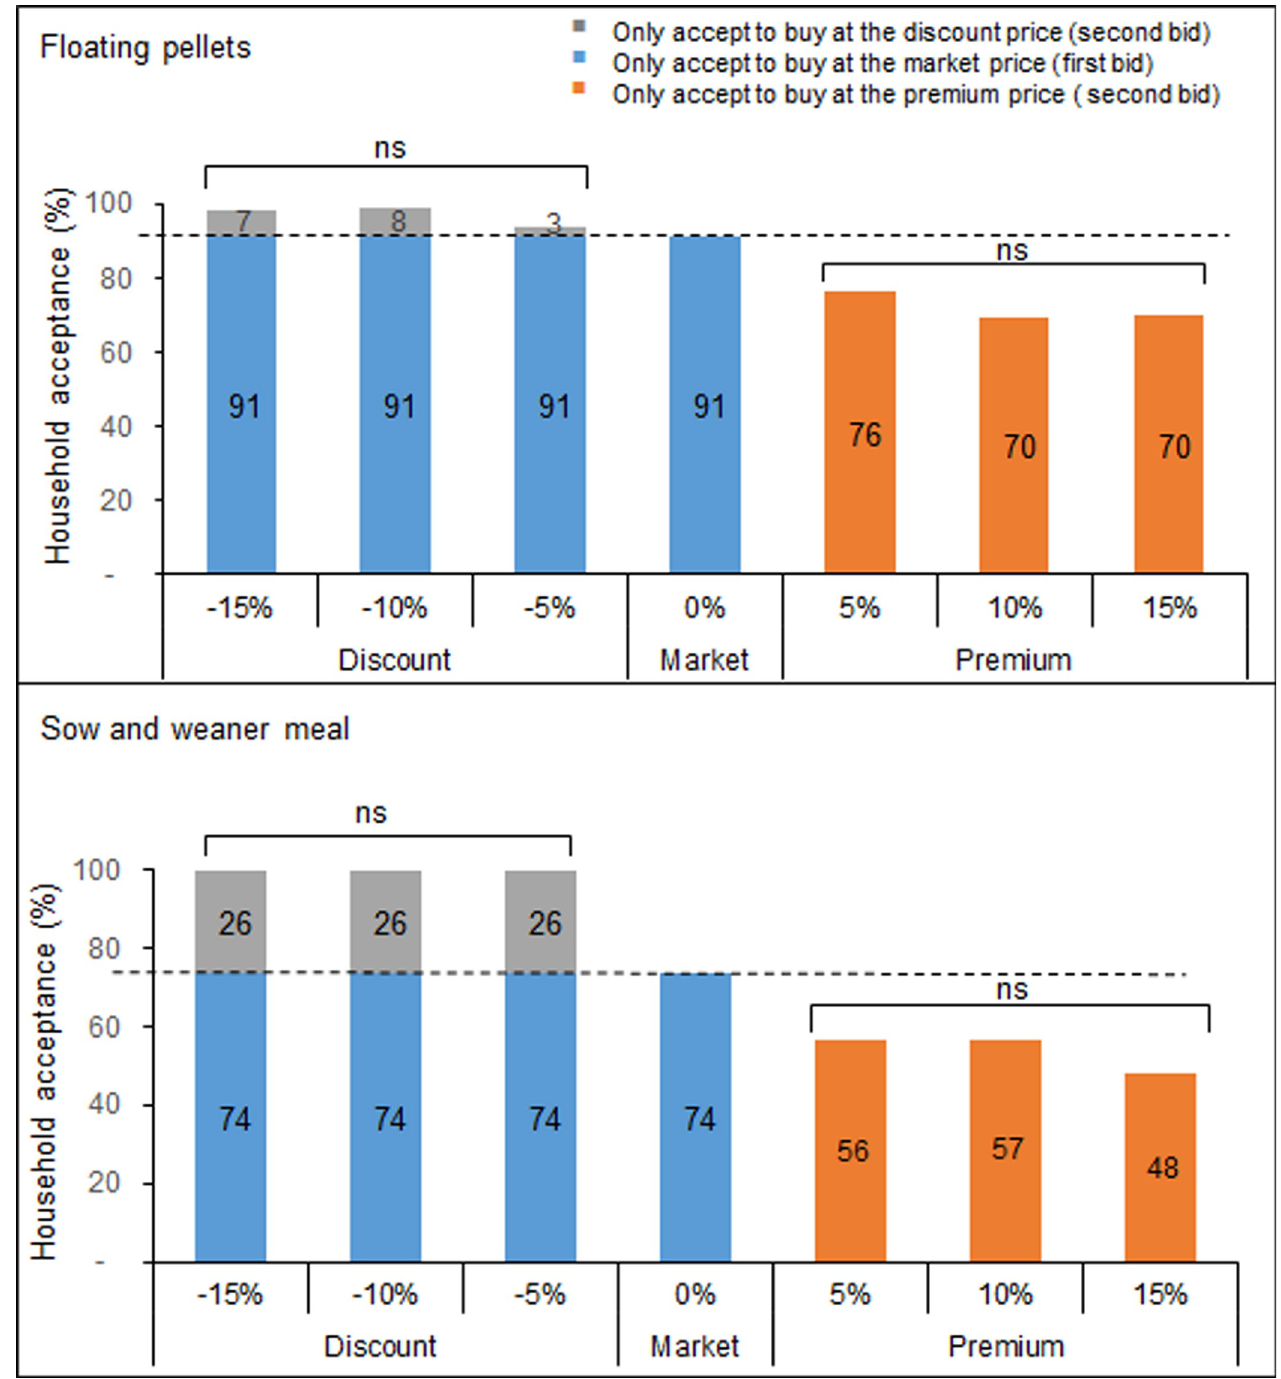
Fig 6. Effect of bid offers on willingness to pay (WTP) level among fish and pig farmers. The broken line indicates the market price. Bars with “ns” are not significantly different, P < 0.05, Chi-squared test. Floating pellets = feed that has been compressed and molded into pellets in a pellet mill and float on the surface of water when served to grower and finisher fish stages. Sow and weaner = Feed type for growing pigs up to 55 kg live body weight and adult breeding pigs. Pig finisher = Feed for pigs weighing over 55 kg live body weight.